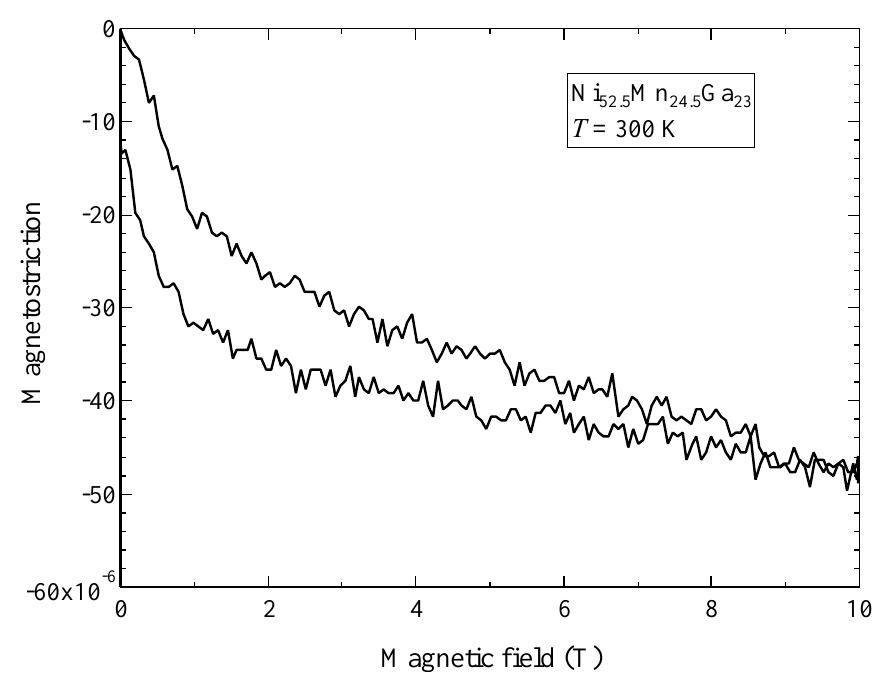
Figure 3. Magnetostriction of Ni